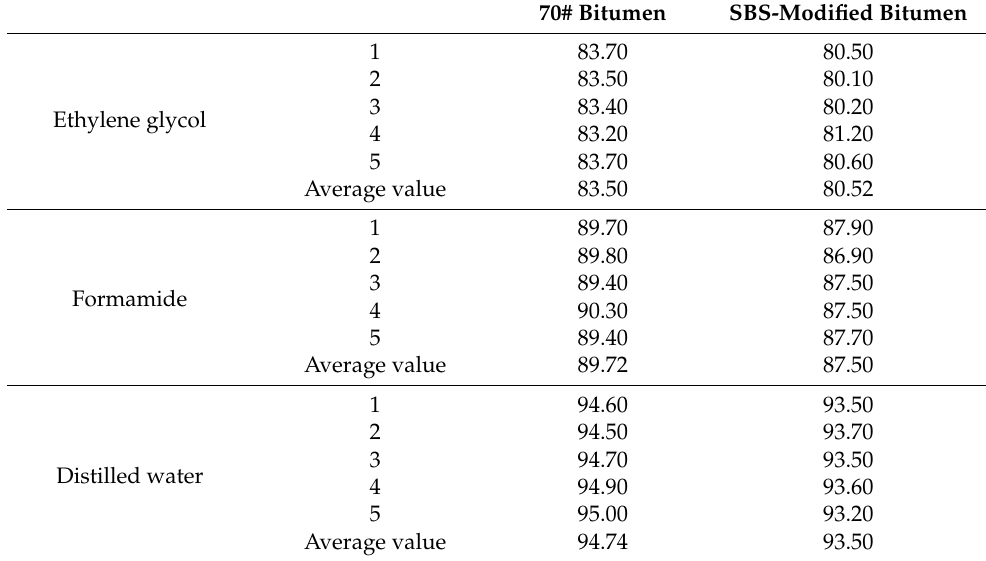
Table 5. Bitumen contact angle results ( ◦ ).